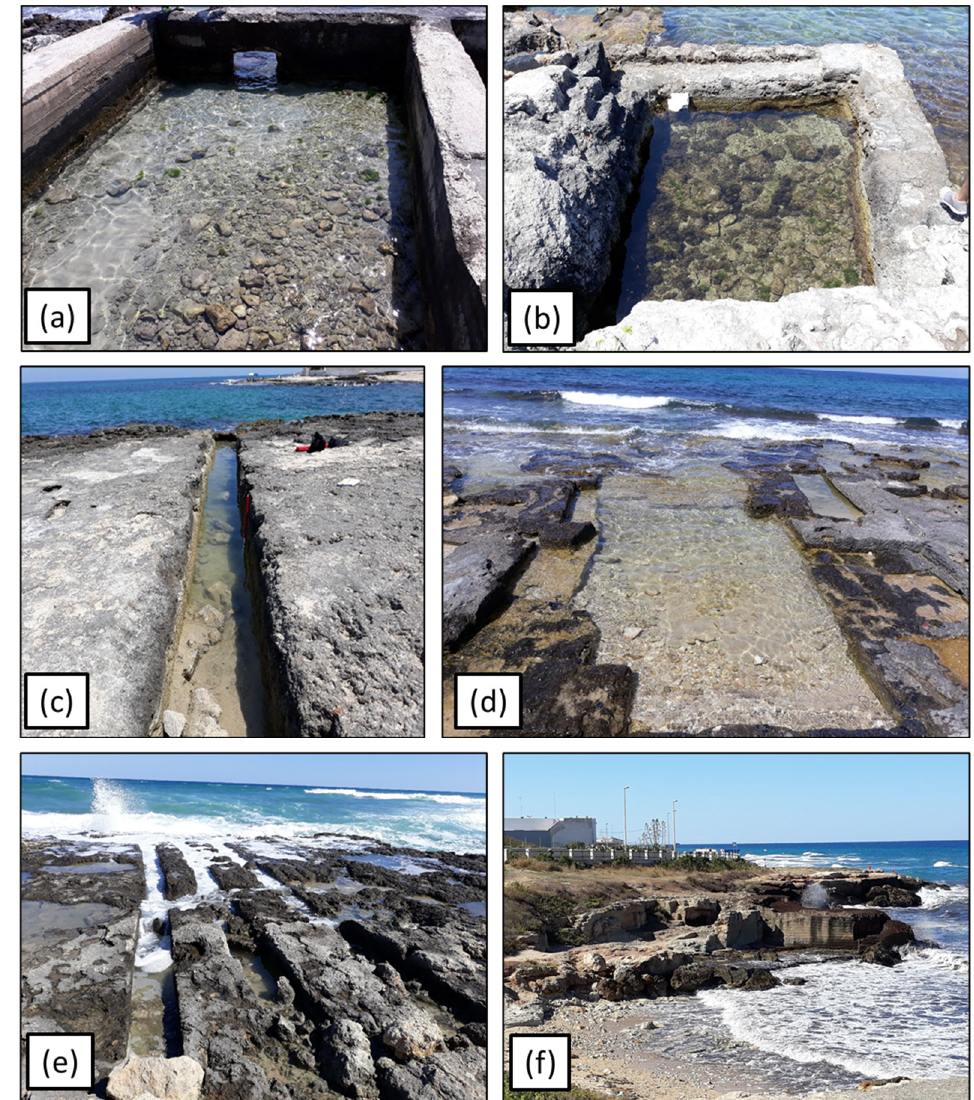
Figure 2. Geoarchaeological markers located in different coastal sites in the province of Bari: ( a ) extraction quarry with drainage channel towards the sea located in Cozze; ( b ) Roman swimming pool located in San Vito-Polignano a Mare; ( c ) channel located in San Vito-Polignano a Mare; ( d ) extraction quarry connected to the sea at the current sea-level, located in Cozze; ( e ) series of drains located at Cozze; ( f ) quarries in Torre a Mare.